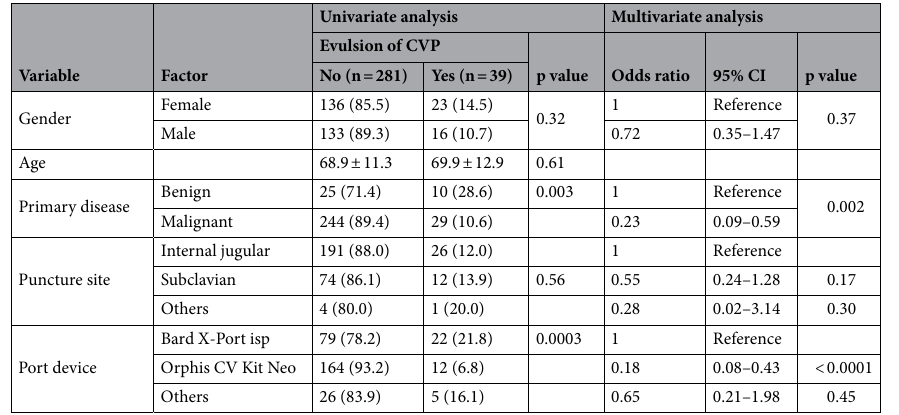
Table 4. Univariate and multivariate analyses to identify variables that are associated with CVP evulsion. CI confidence